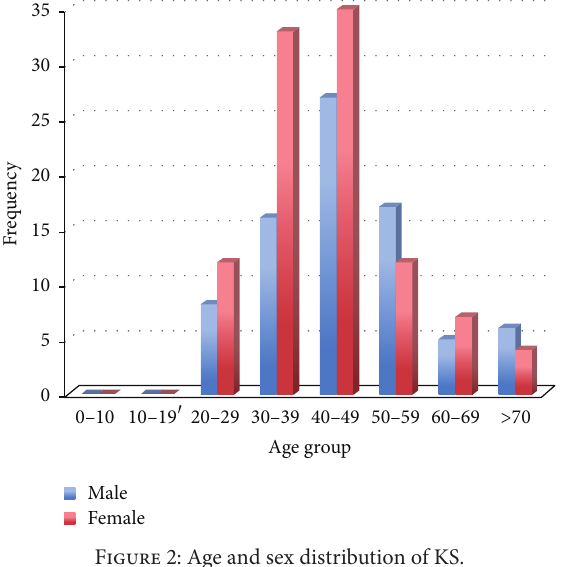
Figure 2: Age and sex distribution of KS.